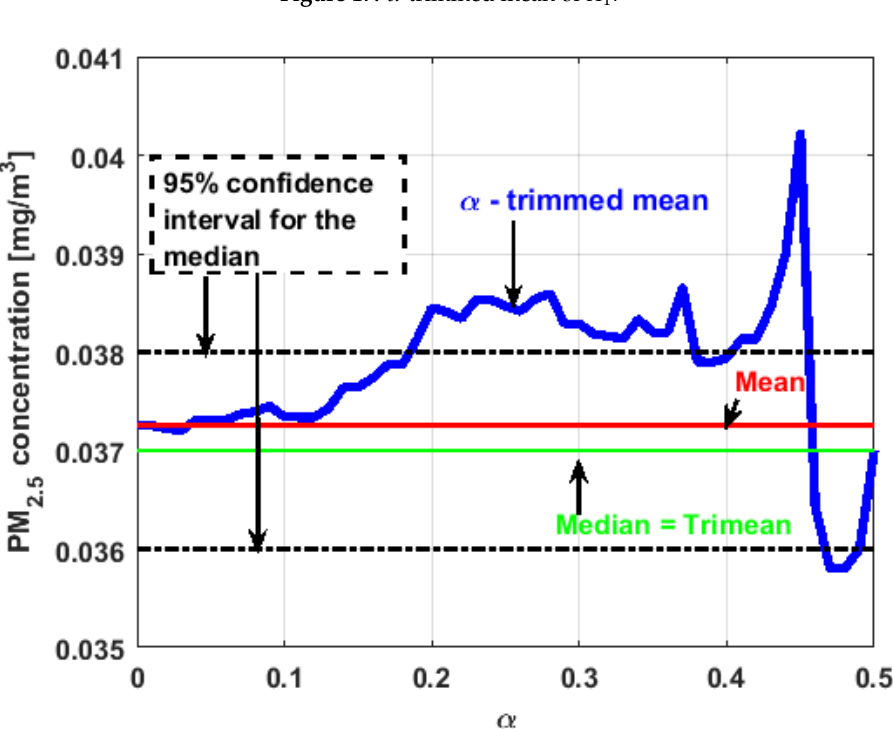
Figure 17. 𝛼 -trimmed mean of 𝑋 1 . Figure 17. α -trimmed mean of X 1 .